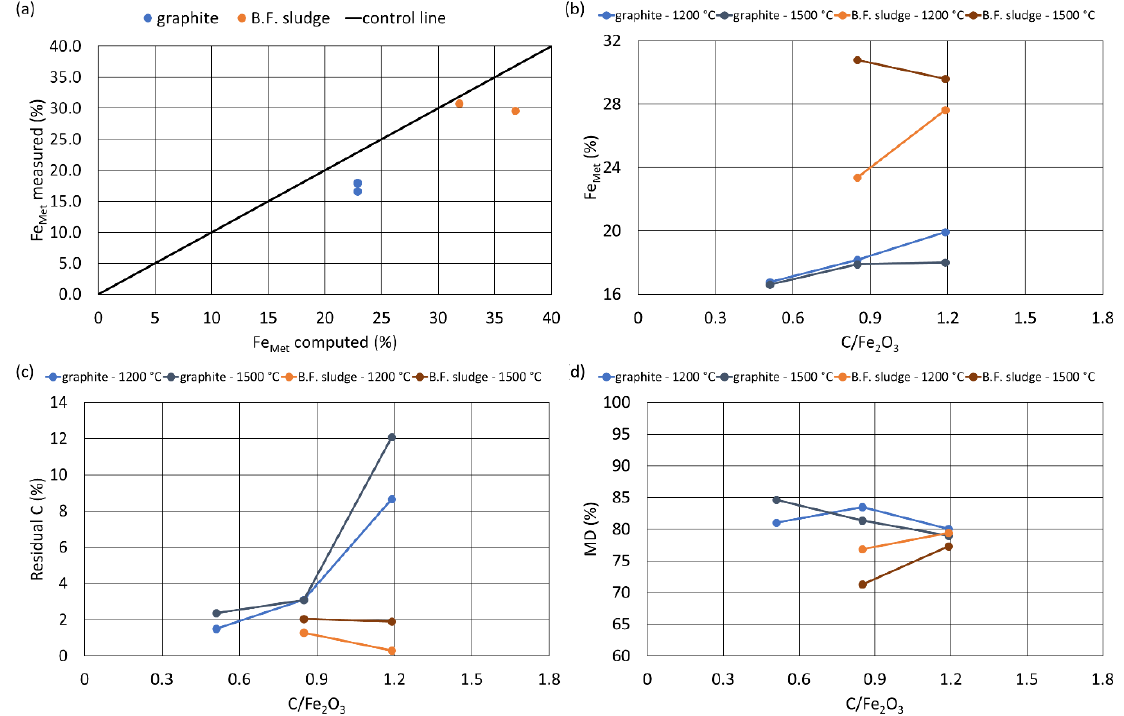
Figure 7. Computed versus measured metallic fraction at 1500 ◦ C ( a ), metallic fraction ( b ), residual C ( c ), metallization degree ( d ) as a function of C/Fe 2 O 3 ratio.